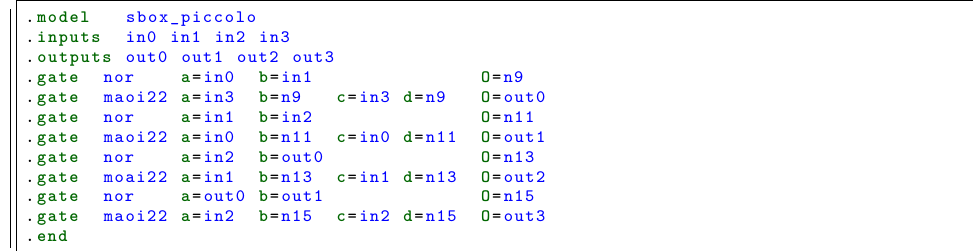
Figure 10: Area-optimized hardware implementation of PICCOLO Sbox using 14.00 GE with the standard cell library of the TSMC 65nm logic process.